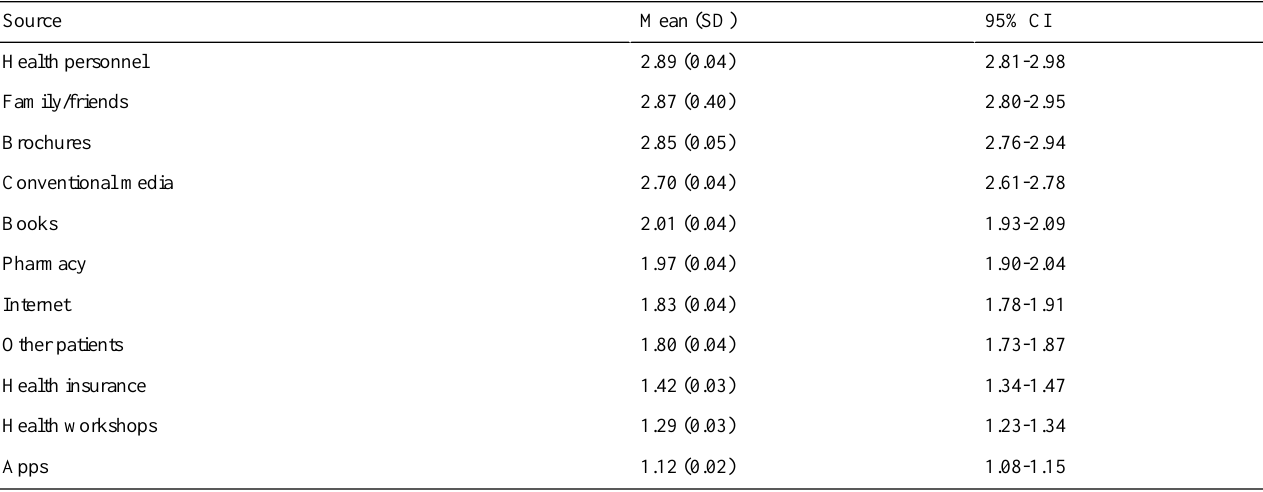
Table 1. Frequency of older adults’use of health information sources